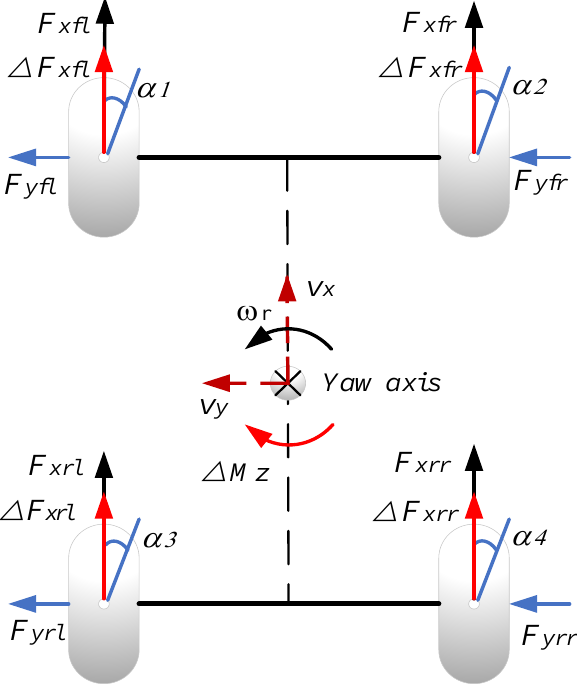
Figure 8. Linear motion diagram of the whole vehicle. The additional yaw moment obtained is distributed by the vertical load proportion of the front and rear axles.